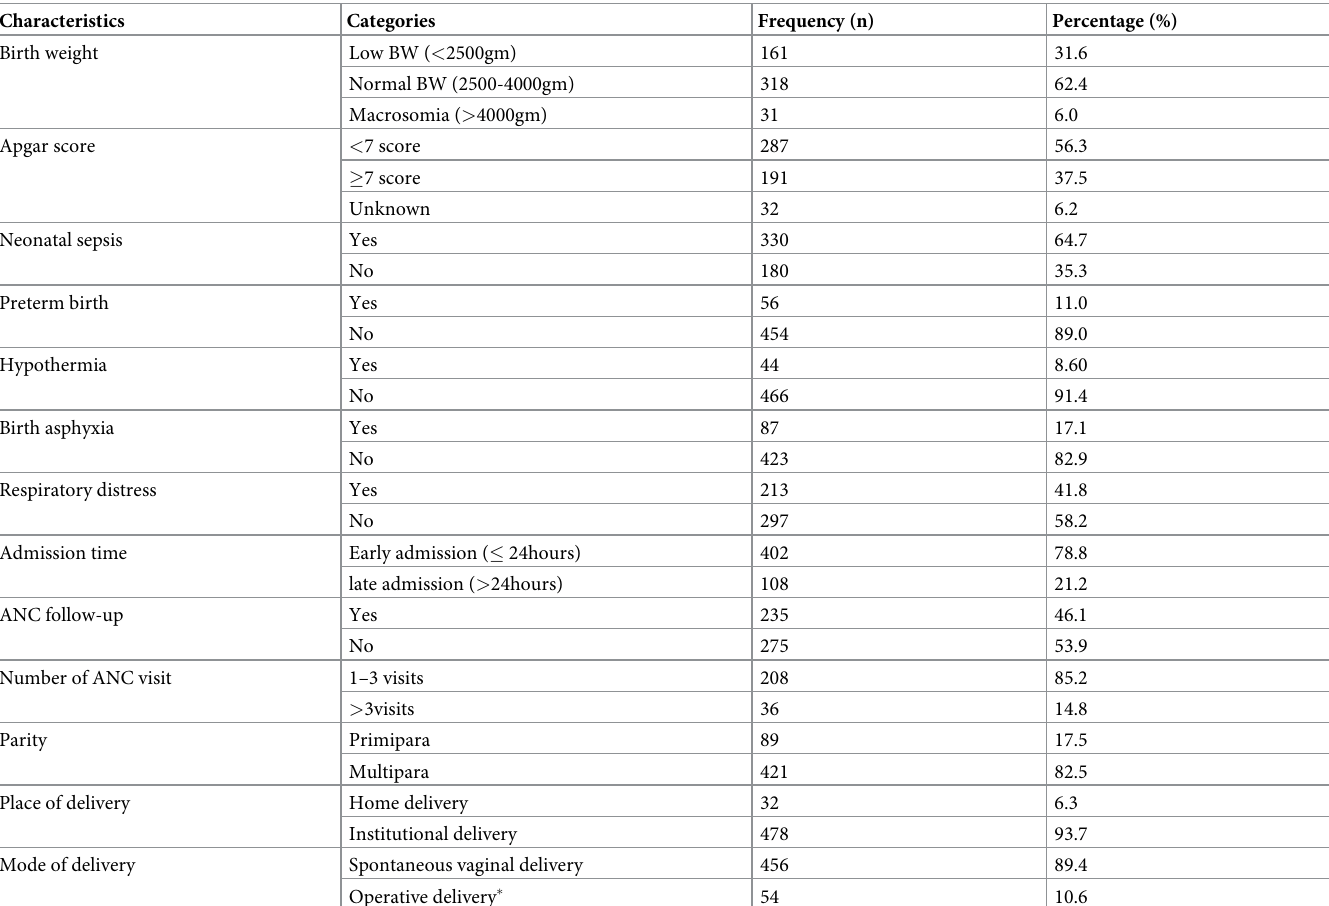
Table 2. Maternal and neonatal related factors among mothers and neonates who admitted to NICU of the selected public Hospitals in Somali Regional State, East- ern Ethiopia, 2020.